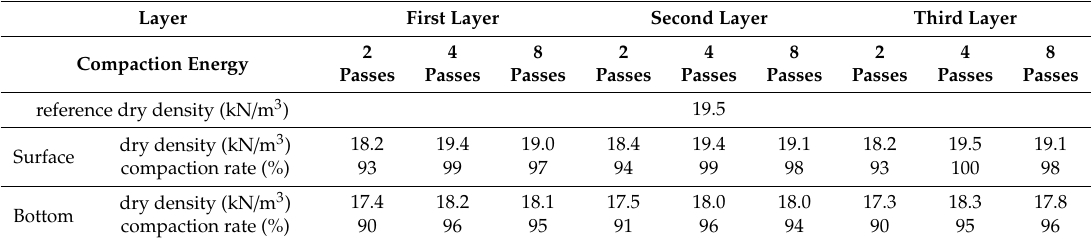
Table 5. The compaction rate according to the compaction energy. Layer First Layer Second Layer Third